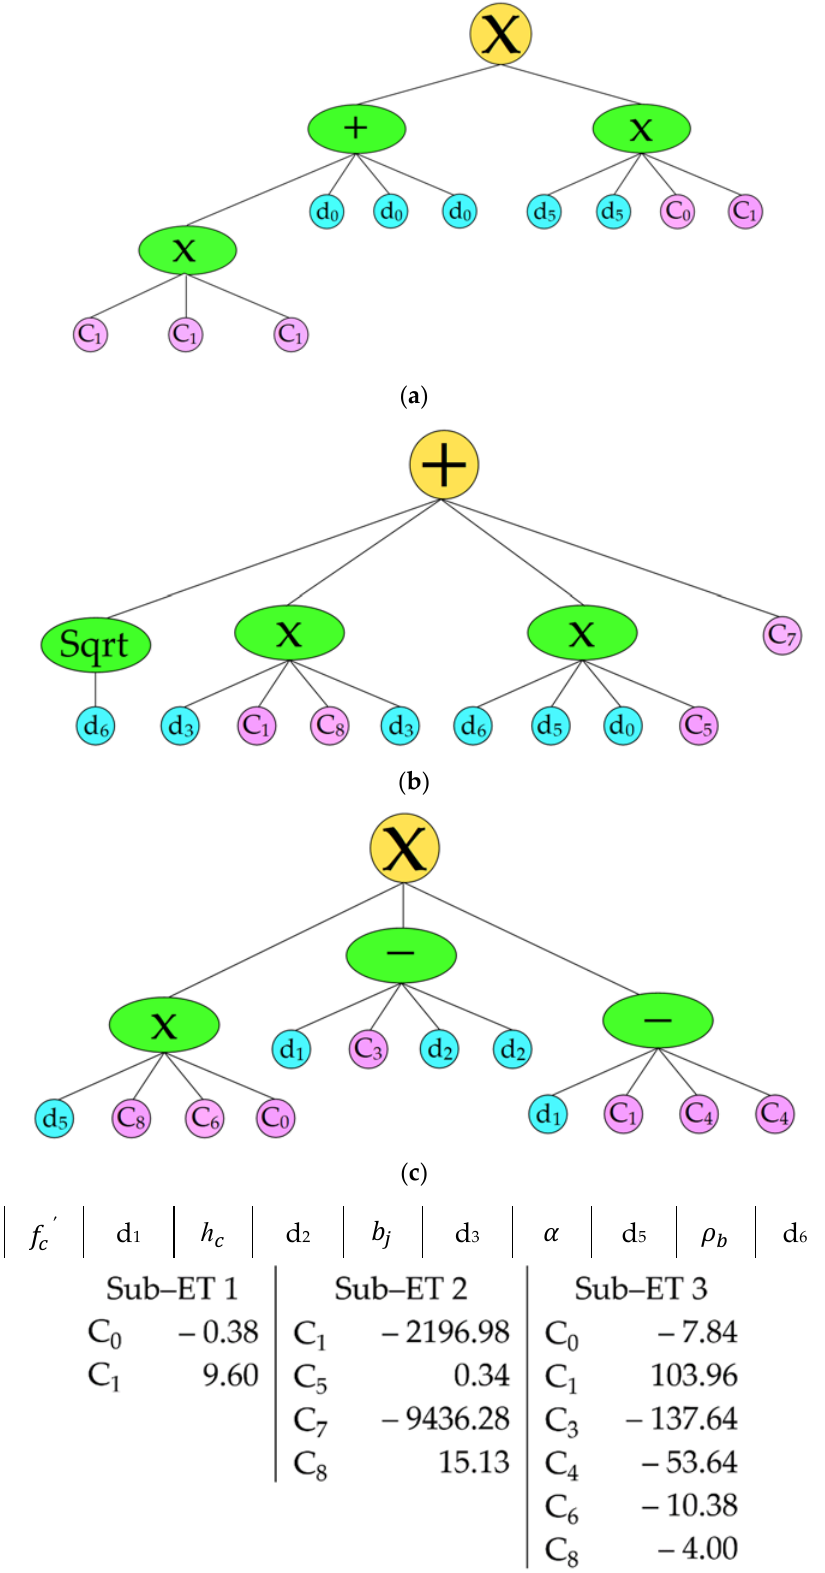
Figure 2. Gene expression tree for the unreinforced exterior joint. ( a ) Sub–ET 1 ( b ) Sub–ET 2 ( c ) Sub–ET 3.